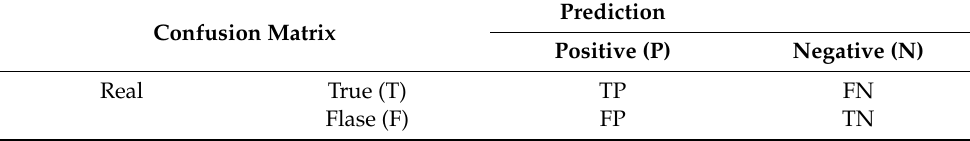
Table 4. Confusion Matrix.